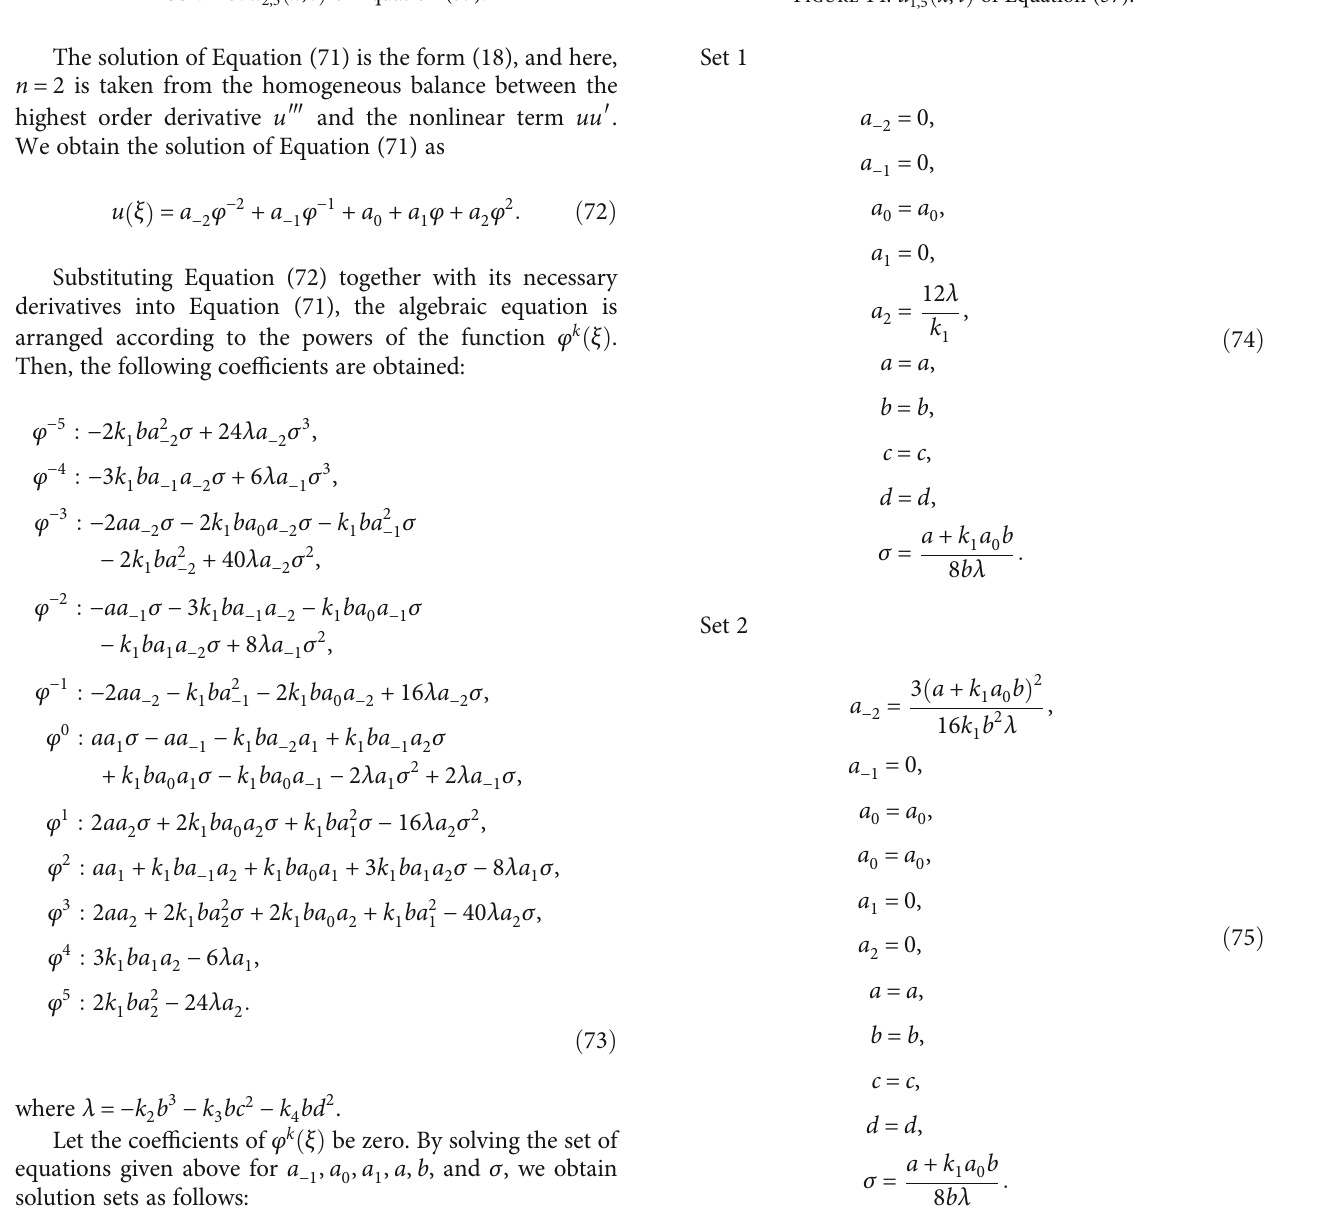
ð x , t Þ of Equation 1,5